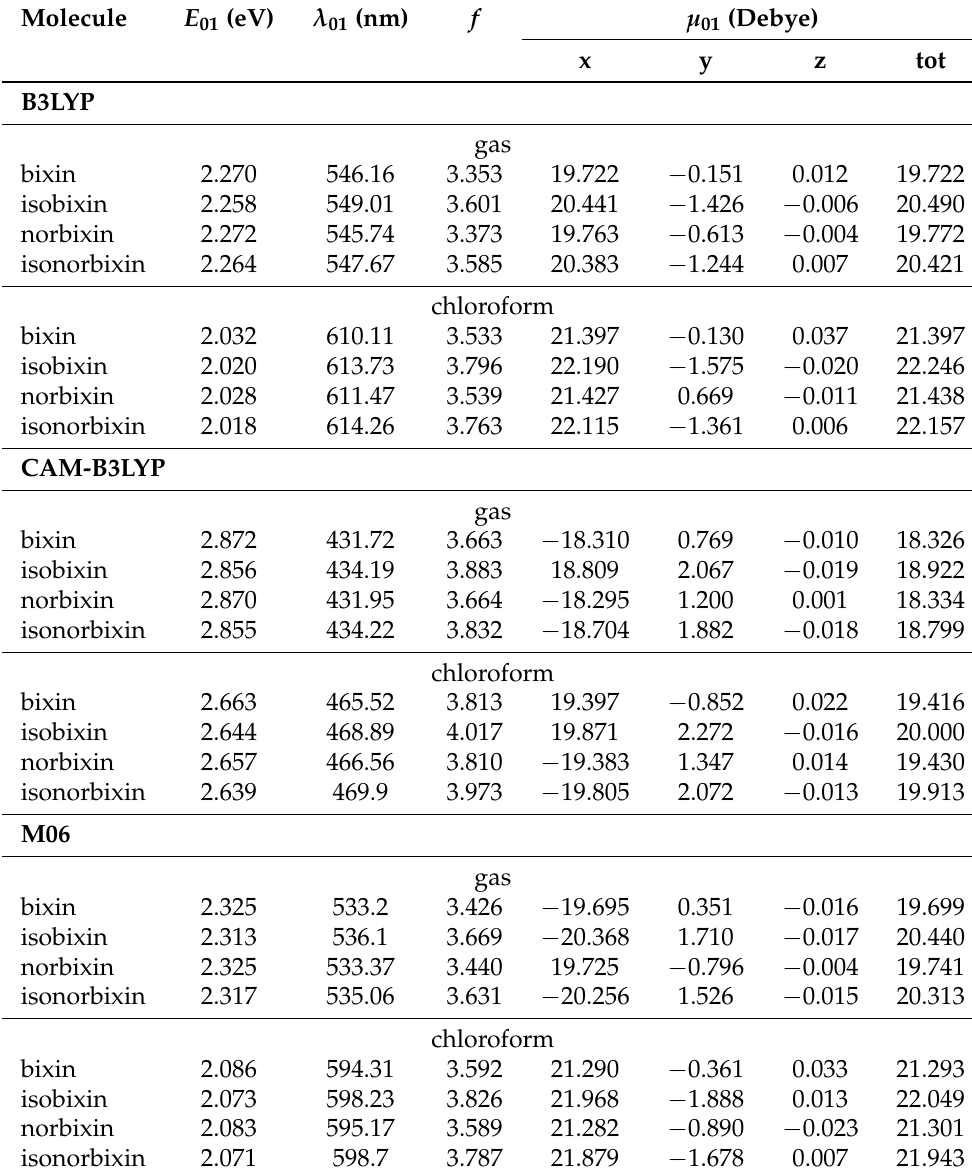
Figure A5. Absorption spectra of molecular dyes in ( a ) gas phase and ( b ) chloroform solution. These results were obtained by employing the 6-31G(d,p) basis set. Table A17. S 0 → S 1 vertical transition energies ( E 01 ), wavelength ( λ 01 ), oscillator strength ( f ), and transition dipole moments ( µ 01 ). These results were obtained by employing the 6-31G basis